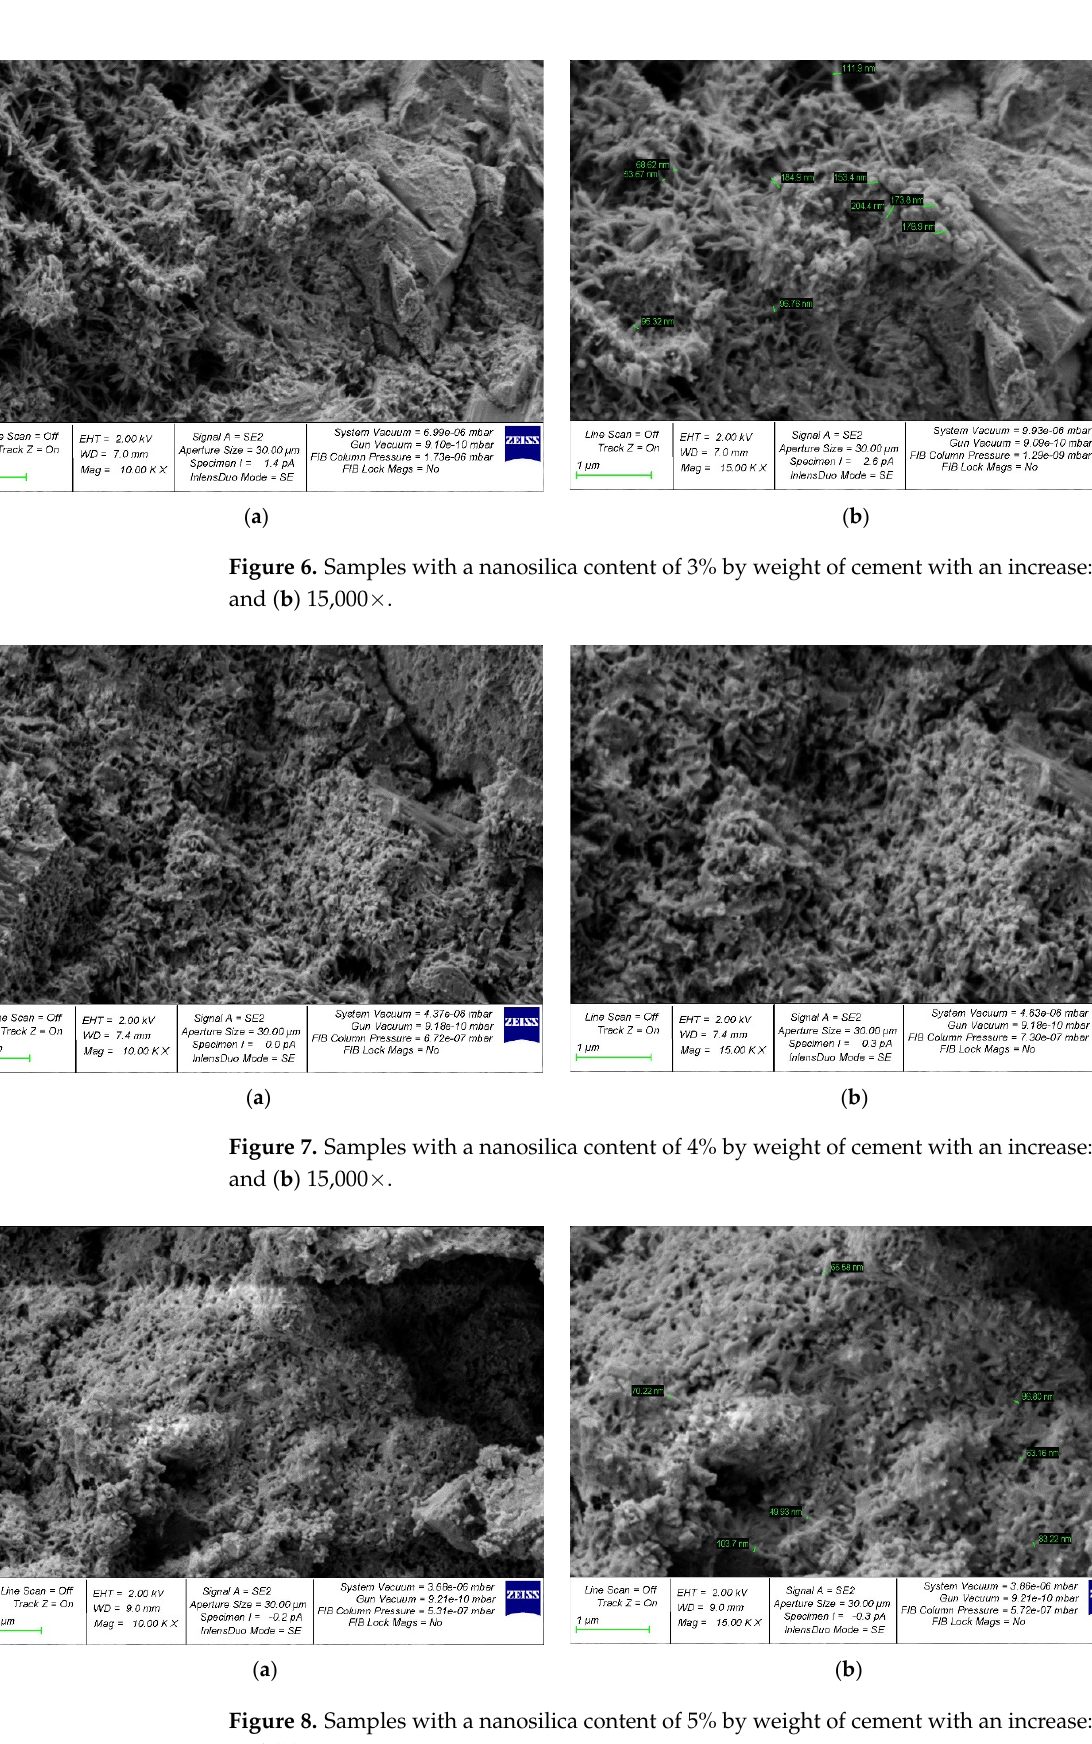
( b ) Figure 9. Samples with a nanosilica content of 5.5% by weight of cement with an increase: ( a ) 10,000× and ( b ) 15,000×. In Figures 5a–9a, at a 10,000× magnification, microdefects can be observed in the ar- eas where microcracks begin to form in the structure of the cement composite. In Figures 5b–9b, at a magnification of 15,000×, it is already possible to consider nanomodifying ad- ditives, places in which the structure is compacted as a result of them, and the appearance of new nanomodified crystallization centers. This scale of photographs of the microstruc- ture allows us to more fully analyze the picture of the nanomodification of the cement composite with nanosilica particles. It is clear, according to the test data for a physical experiment, the optimal dosage of nanosilica in high-strength concrete has a parabolic dependence and there are cases of both the undersaturation of concrete with a nano-modifier, which leads to a deterioration in its structure and properties, and possible cases of the oversaturation of concrete with nanosilica, which also reduces its characteristics. and degrades its structure. This can be clearly observed on the microphotographs, in which, at the optimal dosage of nanosilica, the densest structure is observed with the densest packing of particles, the smallest num- ber of microstructural defects, and, in general, the relationship of “the most perfect struc- ture—the best properties” is also clearly observed (Figure 7). In the case of undersatura-